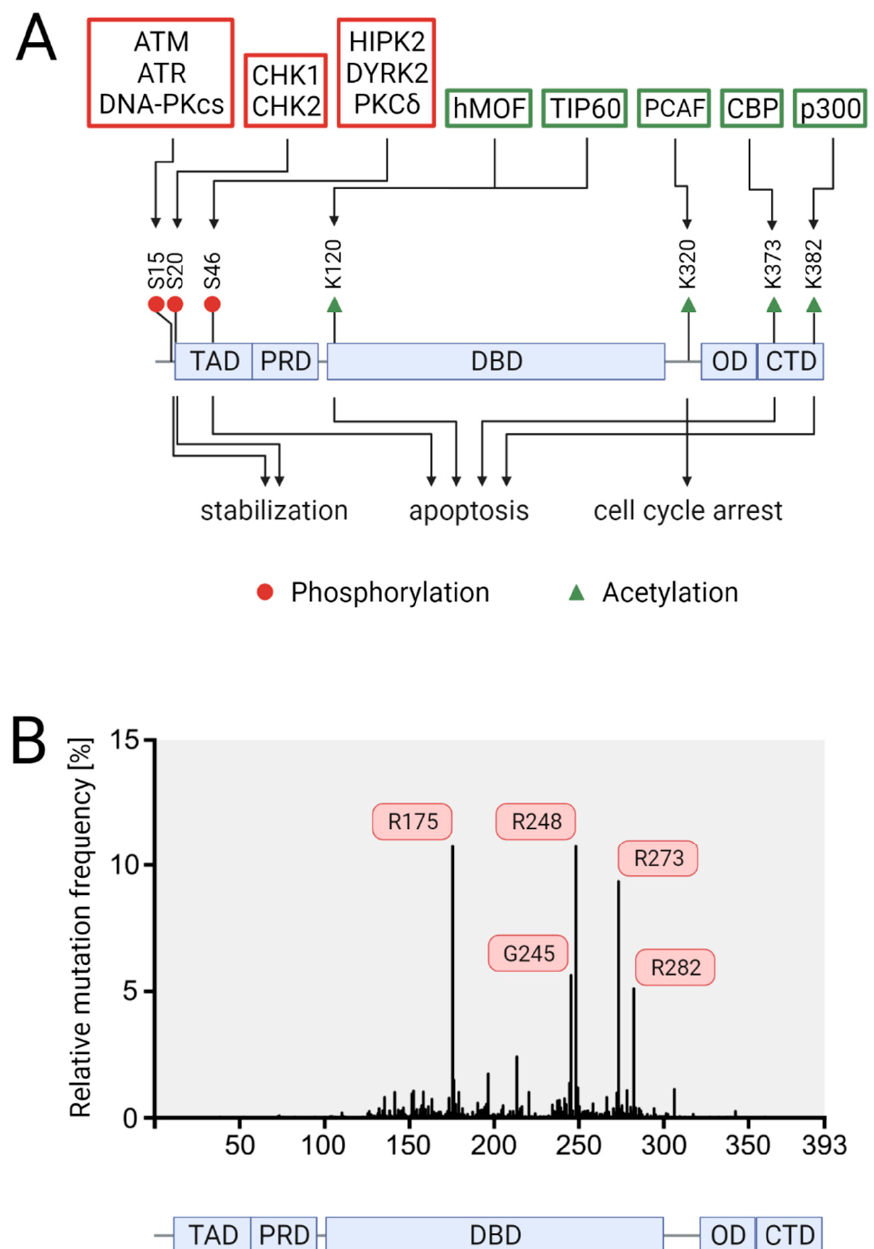
Figure 2. Schematic representation of the domain structure of p53, the impacts of selected post- translational modifications (PTMs), and the prevalence of p53 mutations. ( A ) Effects of selected p53 PTMs on p53 stability and cell fate. The enzymes catalyzing these PTMs are shown above the modified residues, whereas the impacts of these PTMs are depicted below. ( B ) Somatic p53 mutations in CRC according to the IARC TP53 mutation database. A schematic cartoon representing the domain structure of p53. The aligned histogram represents the relative mutation frequency at each position along the p53 protein-coding sequence, based on data of 3607 CRC samples with somatic mutations derived from the IARC TP53 database (R20, July 2019). The five most common mutations are labeled. Transactivation domain (TAD), DNA-binding domain (DBD), oligomerization domain (OD), and carboxyl-terminal domain